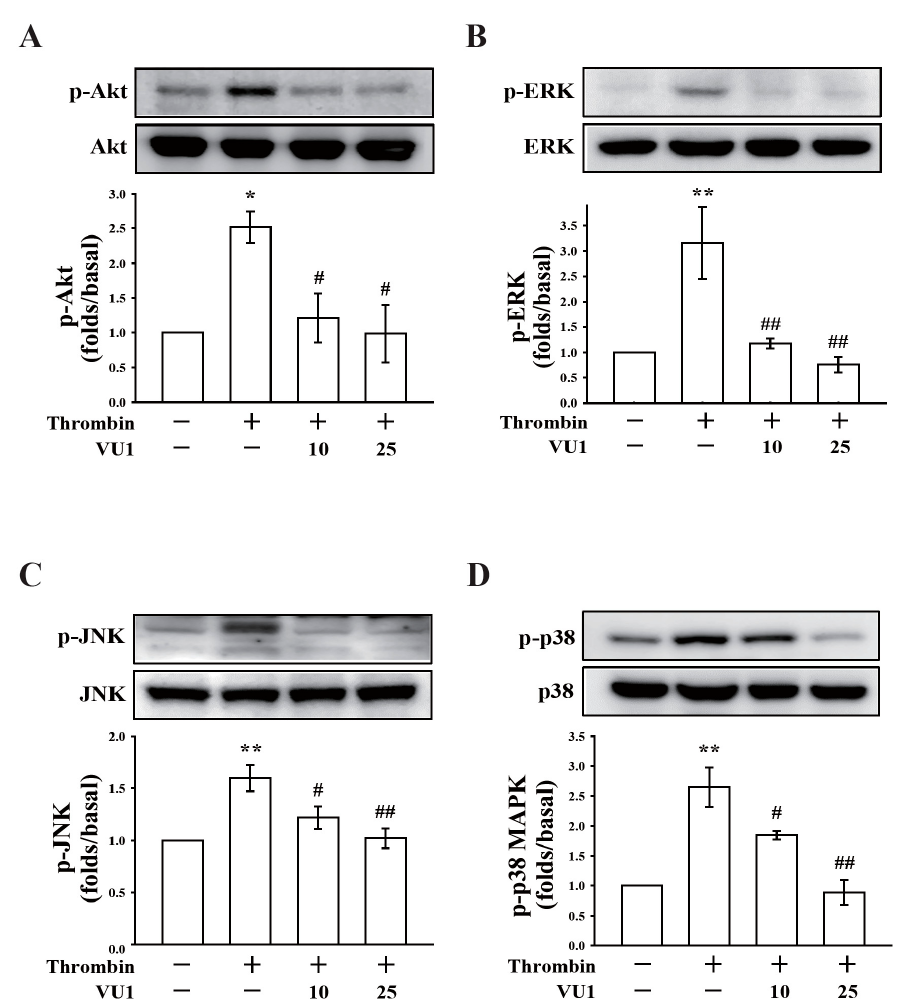
Figure 3. Effects of VU1 on the phosphorylation of Akt and mitogen-activated protein kinases (MAPKs). Washed platelets (1.2 × 10 9 cells/mL) were preincubated with DMSO or VU1 (10 and 25 µ M), and thrombin (0.01 U/mL) was subsequently added to trigger the phosphorylation of Akt, extracellular signal-regulated protein kinase (ERK), anti-c-Jun N-terminal kinase (JNK), and p38 MAPK. Cells were then collected, and subcellular extracts were analyzed through Western blotting. Data ( A – D ) are presented as means ± SEM ( n = 3). * p < 0.05 and ** p < 0.01, compared with the resting group; # p < 0.05 and ## p < 0.01, compared with the thrombin (positive) group.